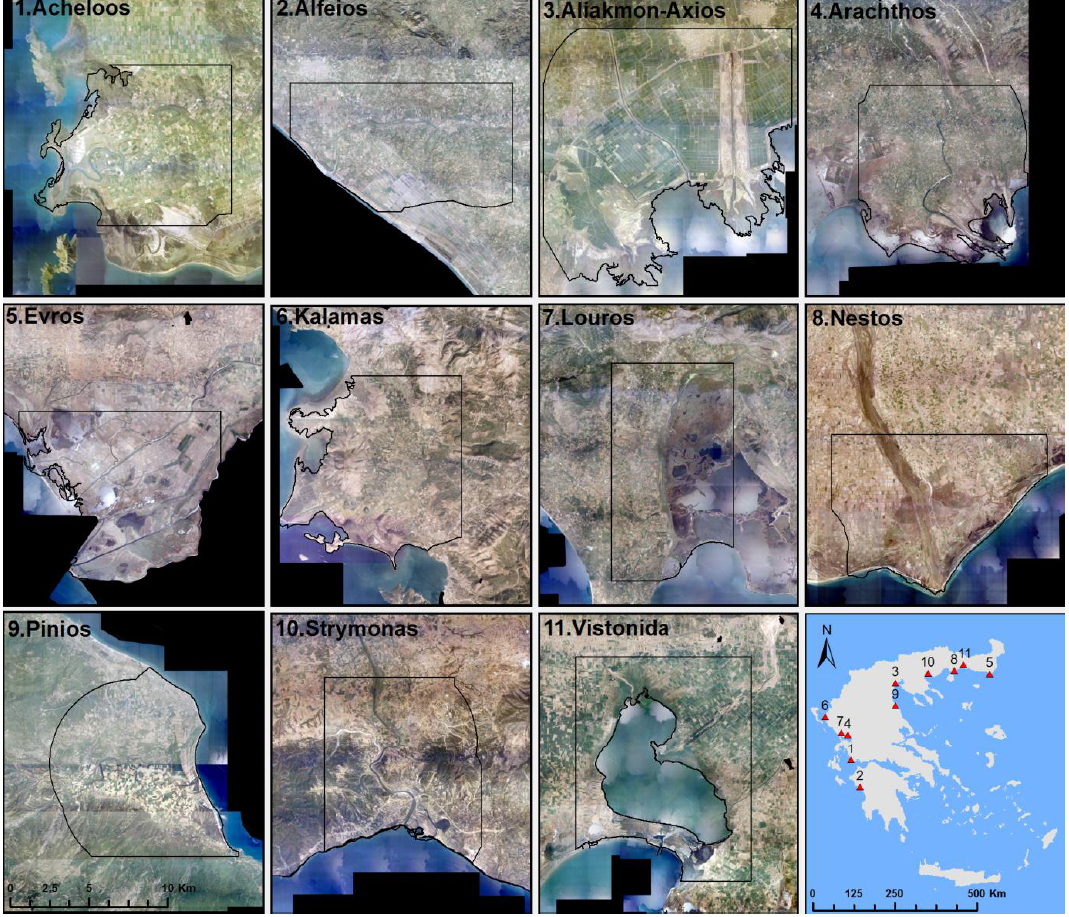
Figure 1. Geographical distribution and maps of the deltaic areas used in this study.